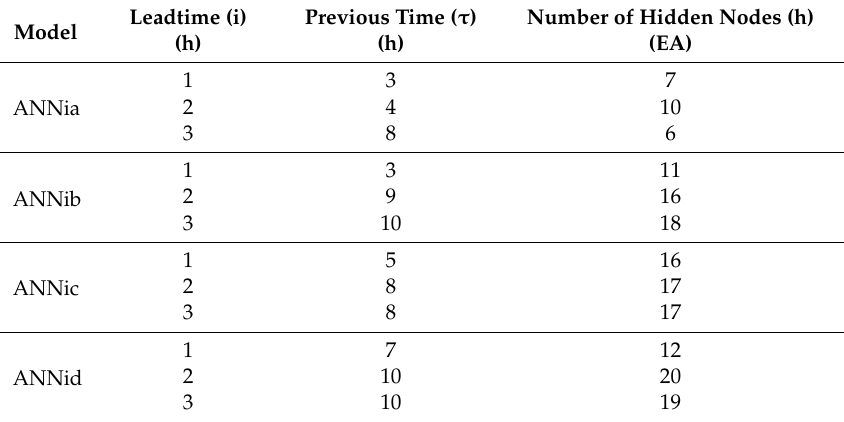
Table 3. Optimal configuration of ANN models.